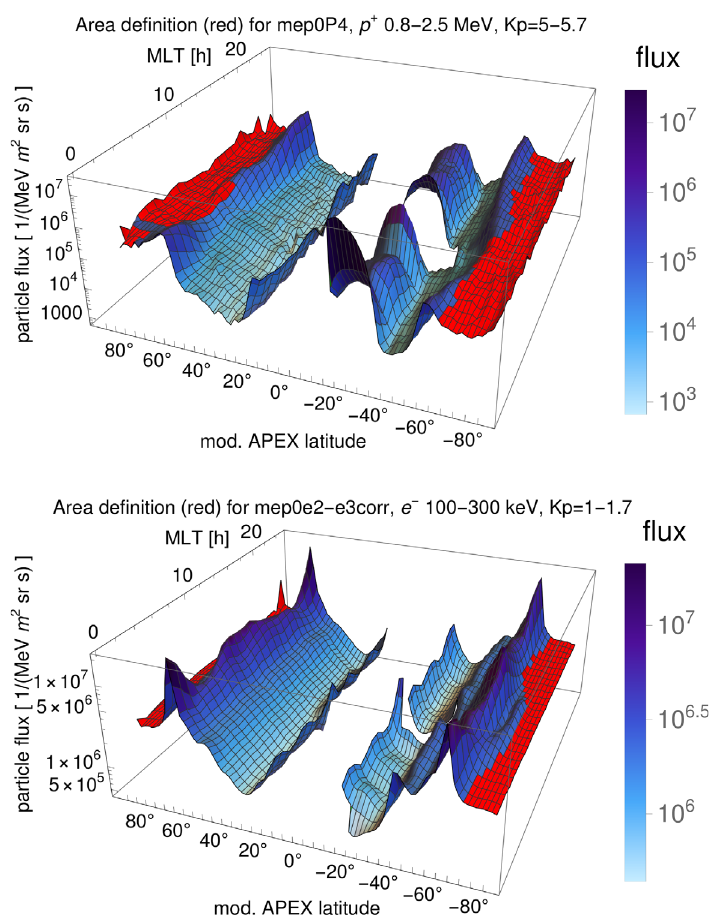
Figure 5. Bin-averaged particle fl ux distribution for the entire data set for a particle channel with weak auroral contribution (top) and strong auroral contribution (bottom). The PPFD area is indicated in